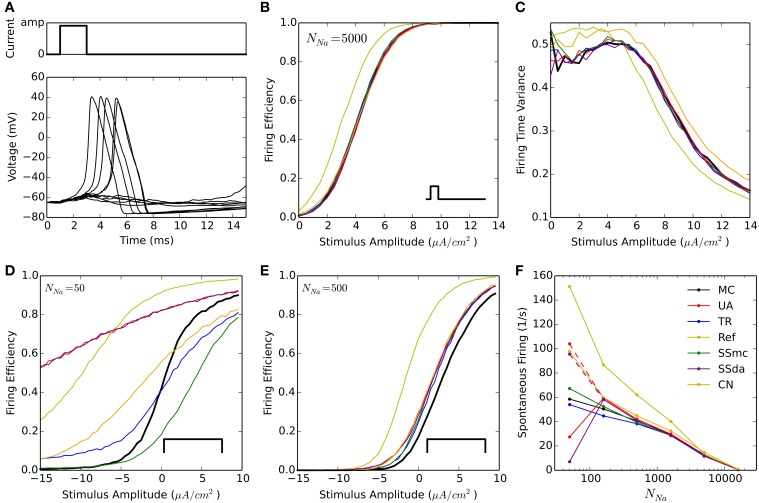
Stochastic simulations of the HH model in current clamp configuration. (A) 10 sample voltage traces obtained with the DA simulation, showing the stimulus at the top. Amp = 4.5 μA/cm2. (B) Firing efficiency, expressed as the fraction of simulations in which an action potential was elicited, out of 10,000 sweeps. Simulations performed with NNa = 5000, NK = 1500. The inset represents the type of stimulus. (C) Variance of the firing time at different amplitudes of the pulse, for the same simulations shown in (B). (D,E) Firing efficiencies obtained with a constant pulse (inset) of the indicated amplitudes with NNa = 50, NK = 15 (D) and NNa = 500, NK = 150 (E). (F) Mean number of spikes per seconds obtained in 500 s simulations (dt = 0.5 μs) without stimulus at different number of sodium channels NNa. NK = 0.3 ∗ NNa. Segmented lines represent data obtained with dt = 0.1 μs (UA) and dt = 0.02 μs (SSda) The algorithms are indicated as follow: MC, Markov chains (Gillespie's algorithm); UA, unbounded DA with absolute values in the stochastic terms (Orio and Soudry, 2012); TR, truncated and restored DA (Huang et al., 2013a); Ref, reflected DA (Dangerfield et al., 2012); SSmc, stochastic shielding approximation (Schmandt and Galán, 2012); SSda, stochastic shielding with DA approximation; CN, colored noise (Güler, 2013).